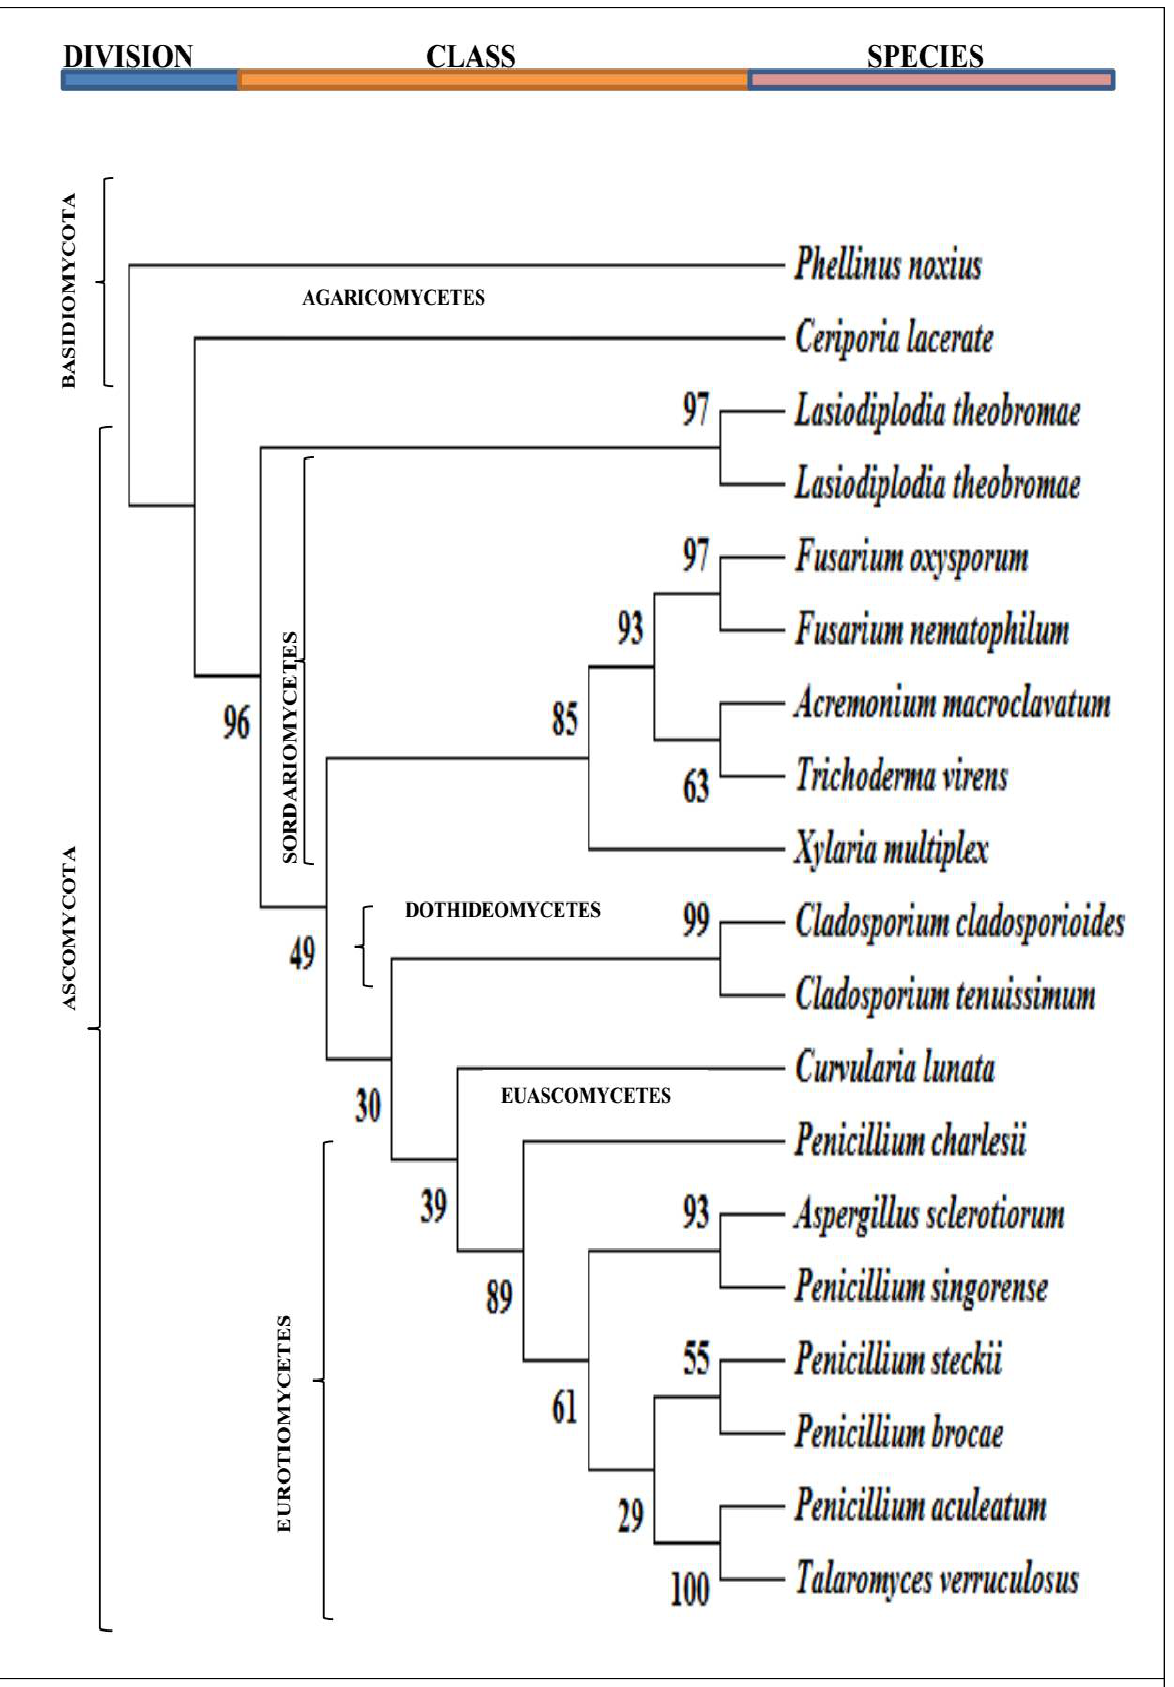
Figure 1: Neighbour-Joining phylogenetic tree showing the phylogenetic relationship of fungi isolated from orchids in the MCR. Bootstrap values are based on percentages of 1000